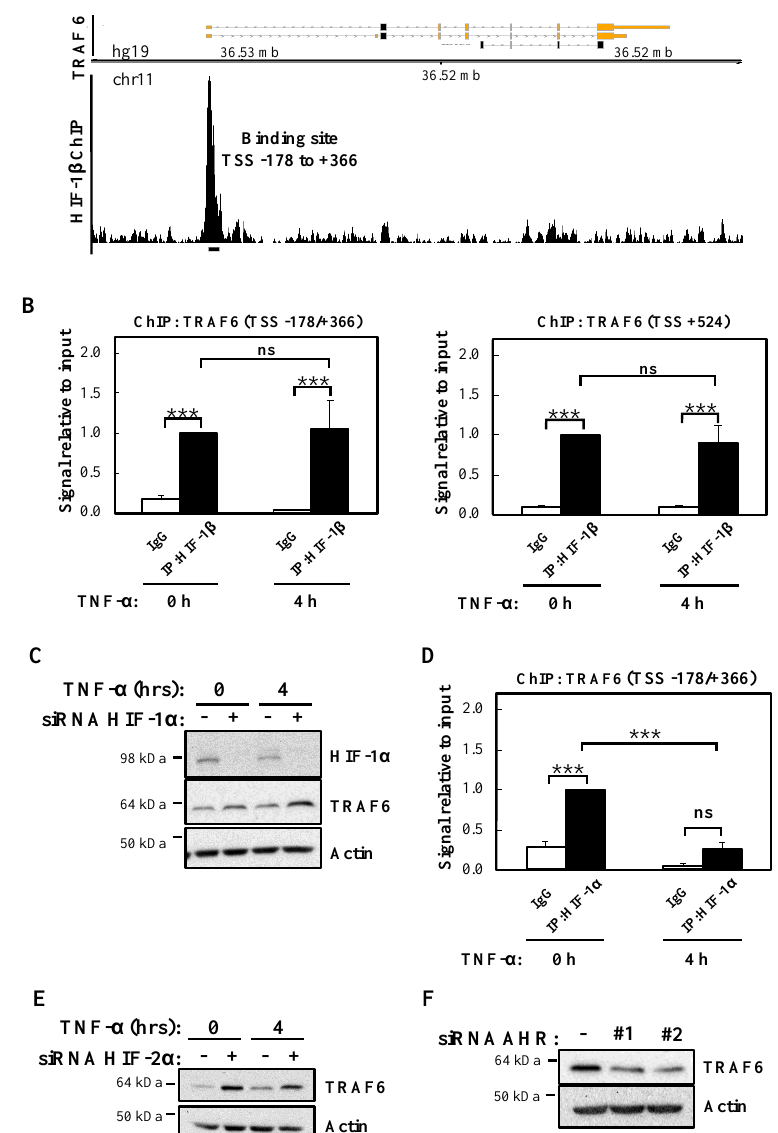
Figure 6. HIF-1 β binds to TRAF6 gene and regulates its expression independently of HIF-1/2 α . A. Coverage tracks of HIF-1 β ChIP-seq at the TRAF6 gene in T47D cells. TSS = transcription start site. B. ChIP for HIF-1 β was performed in lysates derived from HeLa cells treated or not with 10 ng/mL TNF- α for 4 h prior to cross-linking and lysis. Occupancy at the indicated sites was analysed by qPCR. In all cases, Rabbit IgG was used as antibody control. Graphs depict mean and SEM from three independent biological experiments. One way ANOVA analysis was performed and levels of significance indicated as follows: ns = not significant, *** p < 0.001. C. HeLa cells were transfected with control or HIF-1 α siRNA oligonucleotide, but also, where indicated, treated with 10 ng/mL TNF- α for 4 h prior to lysis and Western blot analysis. Actin was used as a loading control. D. ChIP for HIF-1 α was performed in lysates derived from HeLa cells treated or not with 10 ng/mL TNF- α for 4 h prior cross-linking and lysis. Occupancy at the indicated site was analysed by qPCR. Rabbit IgG was used as antibody control. Graph depicts mean and SEM from three independent biological experiments. One way ANOVA analysis was performed and levels of significance determined as follows: ns = not significant, *** p < 0.001. E. HeLa cells were transfected with control or HIF-2 α siRNA oligonucleotides, but also, where indicated, treated with 10 ng/mL TNF- α for 4 h prior to lysis and Western blot analysis. Actin was used as a loading control. F. HeLa cells were transfected with control or AHR siRNA oligonucleotides prior to lysis and Western blot analysis. Actin was used as a loading